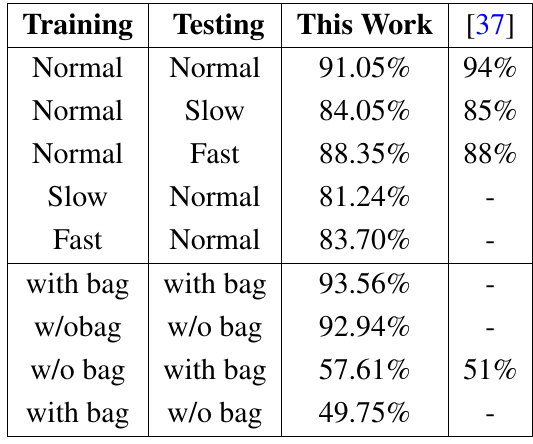
Table 1. The recognition performance of the baseline algorithm for the training/testing data of different